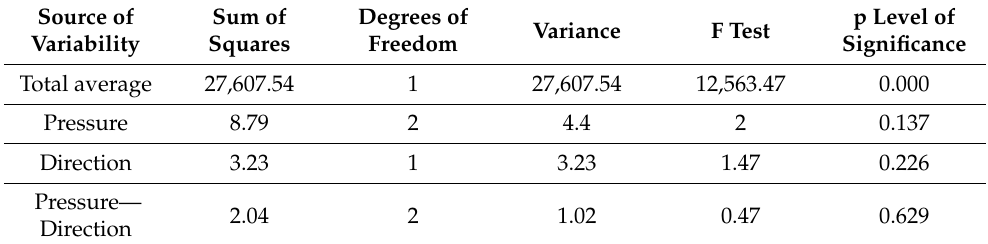
Table 7. Two-way ANOVA—impact